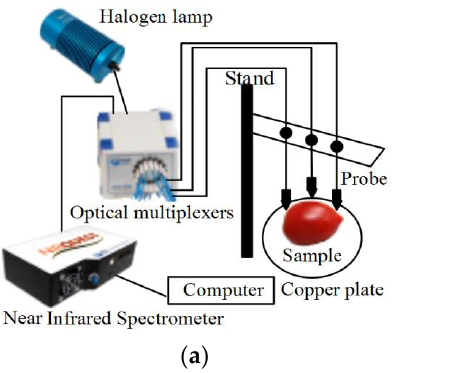
Figure 11. ( a ) The structure of the experimental system. ( b ) A field demonstration of part of the experimental system.